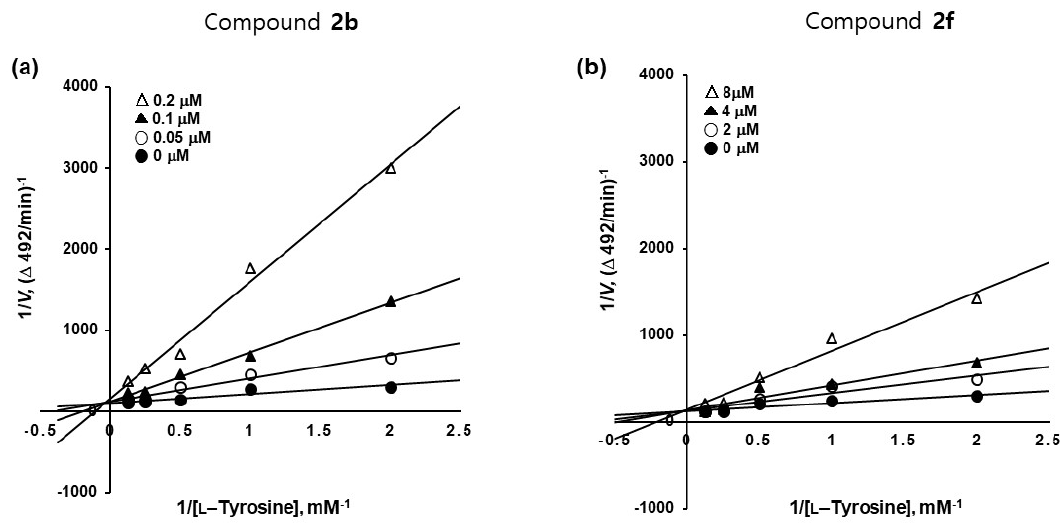
Figure 4. Lineweaver–Burk plots for the inhibition of mushroom tyrosinase by compounds ( a ) 2b and ( b ) 2f . Modes of action of 2b and 2f were determined using Lineweaver–Burk plots. Results are presented as mean values of 1/V, defined as the inverse of increased dopachrome absorbance per min at 492 nm as determined by three independent experiments at five different L-tyrosine concentrations. For 2b , four different inhibitor concentrations were used, 0 µ M (filled circles), 0.05 µ M (unfilled circles), 0.1 µ M (filled triangles), and 0.2 µ M (unfilled triangles), and for 2f , four different inhibitor concentrations were used, 0 µ M (filled circles), 2.0 µ M (unfilled circles), 4.0 µ M (filled triangles), and 8.0 µ M (unfilled triangles). The modified Michaelis–Menten equation was used to calculate 1/V max values (1/V max = (1/K M )(1 + [S]/K i ), where V max is maximum reaction rate, K M is a Michaelis–Menten constant, [S] is L-tyrosine concentration, and K i is the inhibition constant). All experiments were independently performed three times.